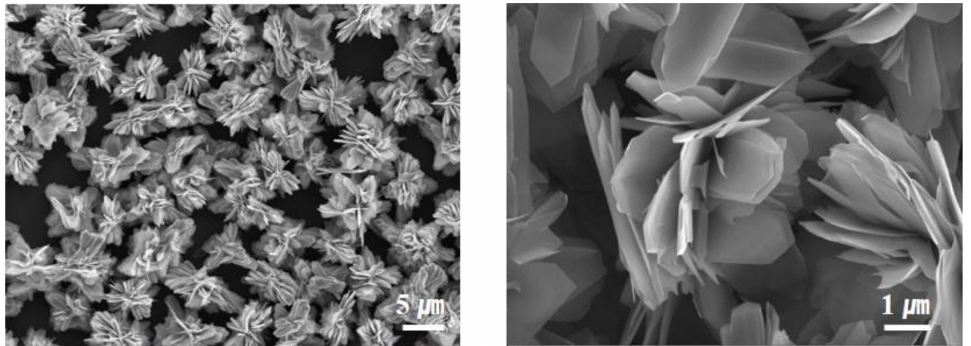
Figure 1. SEM images of F-SnS NPs synthesized in this